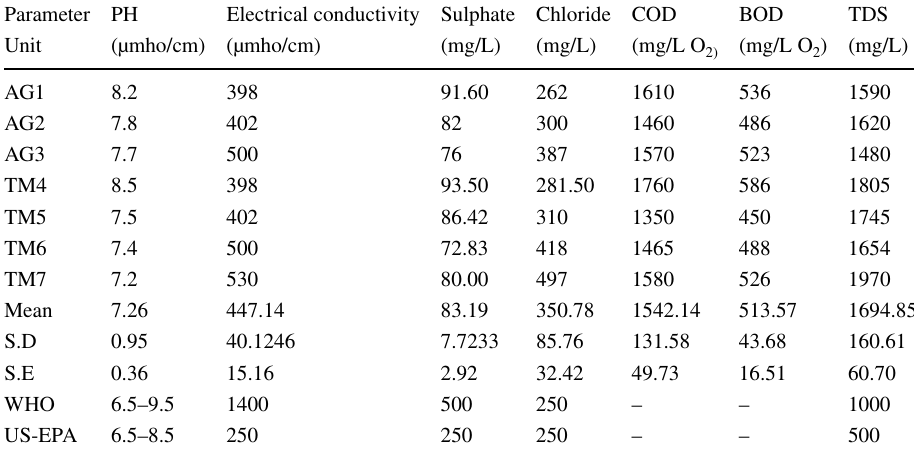
SD standard deviation; SE standard